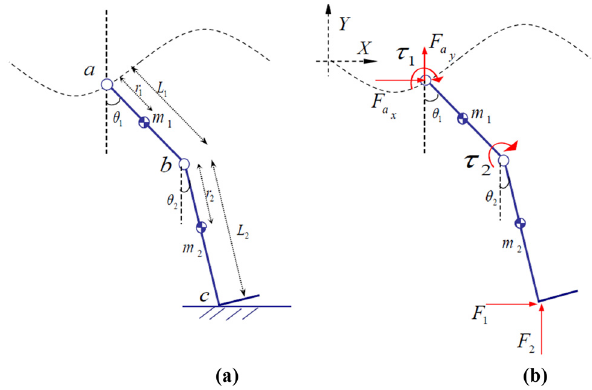
Figure 14: The human lower limb model: ( a ) the simpli fi ed model, ( b ) free - body